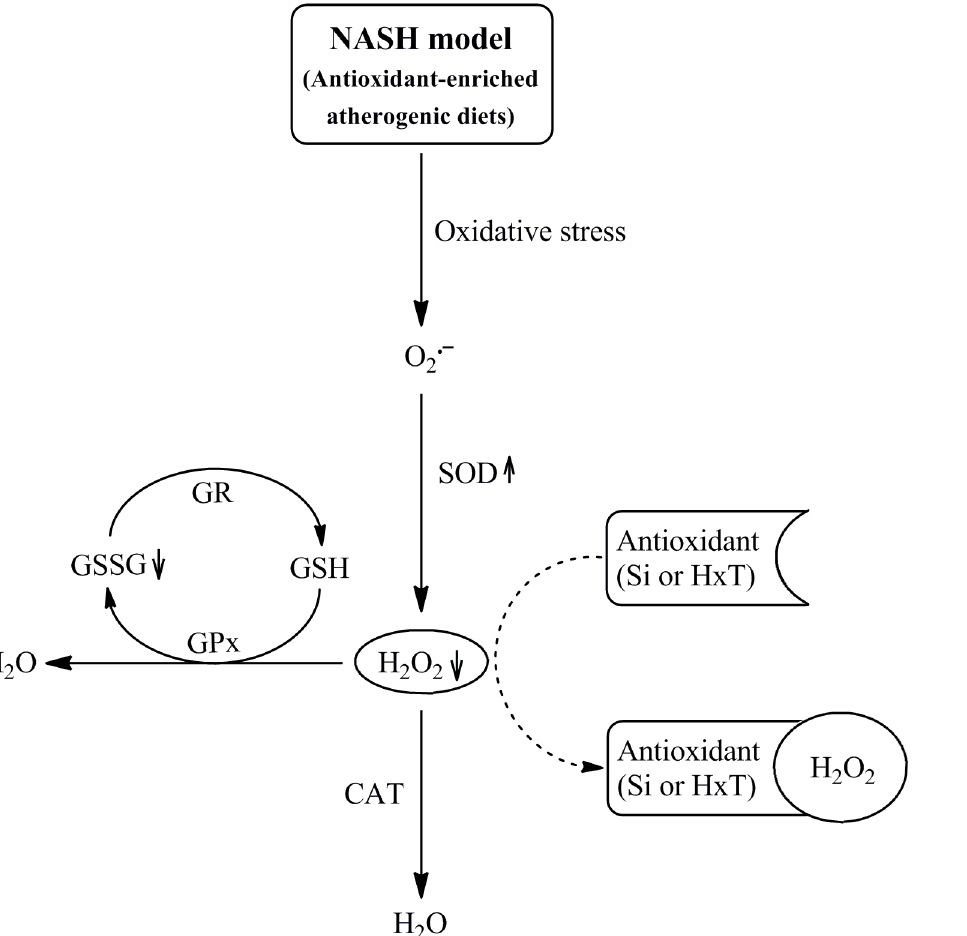
Fig 3. Proposed mechanism by which silicon (Si) or hydroxytyrosol (HxT) neutralize oxidative damage of cholesterol feeding. After high-saturated/ high-cholesterol RP-diets consumption, oxidative stress is produced and SOD is activated. The formed hydrogen peroxide is then removed from the main antioxidant defense system by Si or HxT action, being in consequence not needed the overexpression of CAT or GPx